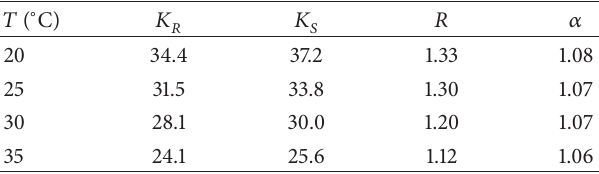
Table 3: Effect of the column